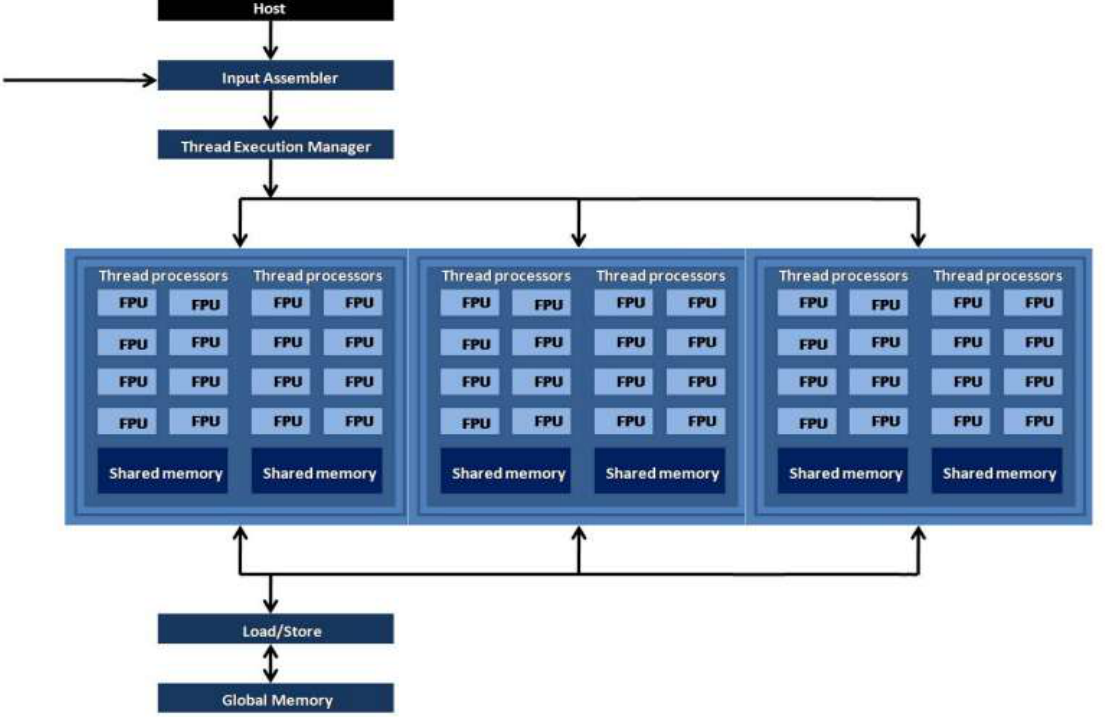
Figure 7. Nvidia Geforce 8800 architecture with 48 cores.